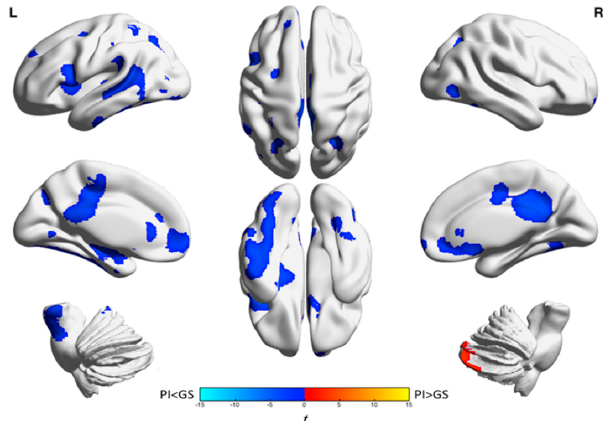
Figure 1. Group differences in relative glucose metabolism during wakefulness. We assessed relative regional cerebral metabolic rate for glucose (rCMR glc ) in a sample of 44 patients with primary insomnia (PI) and 40 good sleeper controls (GS) during morning wakefulness. Patients with PI had lower relative rCMR glc in four clusters spanning the neocortex and brainstem. Patients with PI also had higher relative rCMR glc than GS in the right cerebellum. All clusters were significant at p 3DC_corrected < 0.05. A full list of brain regions involving these clusters is presented in Table 1. The color bar represents t values; blue indicates regions where patients with PI had lower relative rCMR glc than GS and orange indicates regions where patients with PI had higher relative rCMR glc than GS during wakefulness. This figure was originally published in the journal Sleep [52]. Used with permission. Note: L indicates the left side of the brain, R indicates the right side of the brain, and 3DC_corrected indicates that familywise error (FWE) correction and clusterwise extent thresholds were determined using 3dClustSim [53].